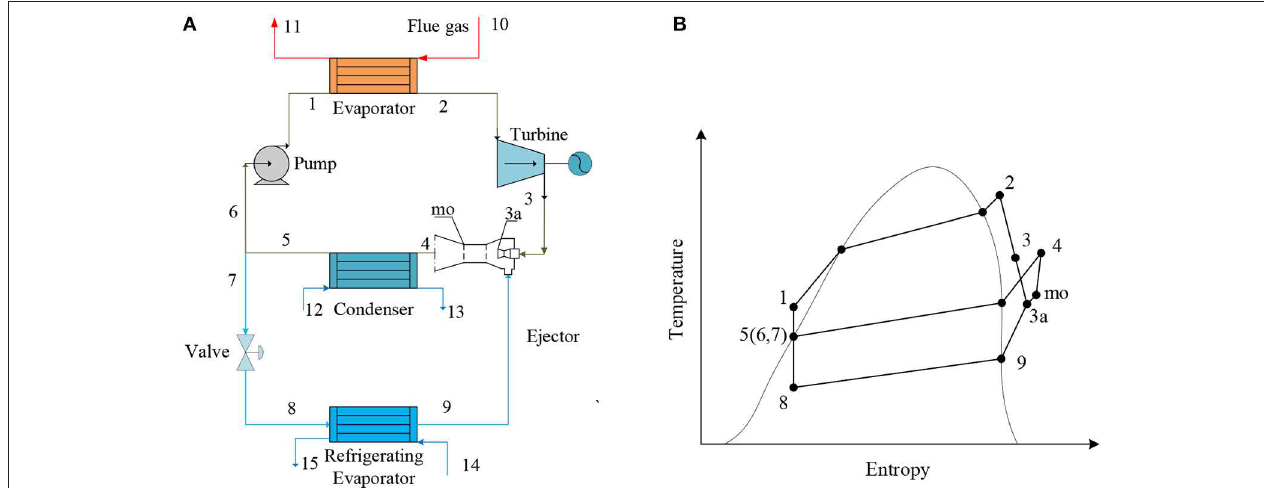
FIGURE 1 | Schematic diagram of the combined power and ejector-refrigeration system: (A) system chart, (B) T-s schematic diagram.